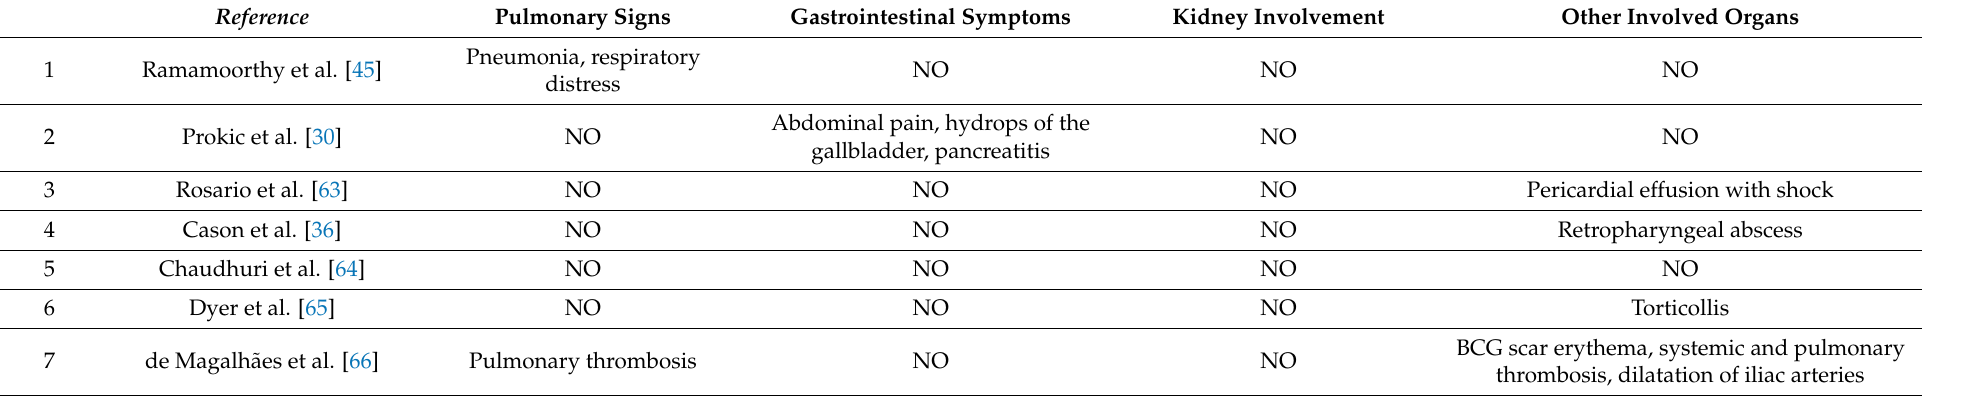
Table 2. List of the non-canonical findings in case reports presenting ‘atypical’ pictures of Kawasaki